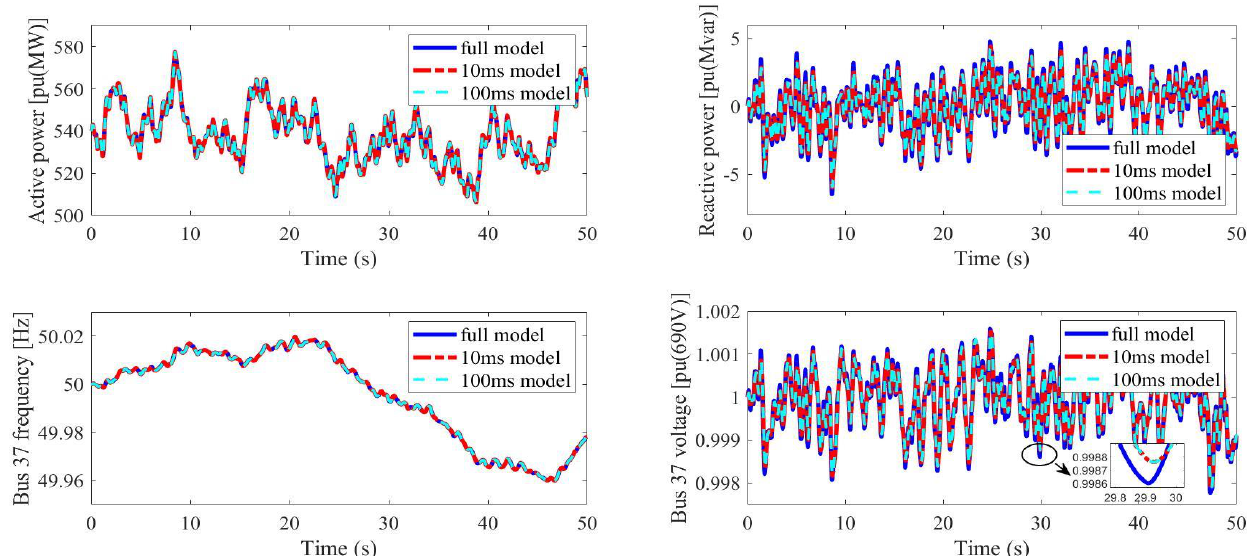
Figure 13. New England 39 bus system, Scenario 3: Weibull distribution wind speed.